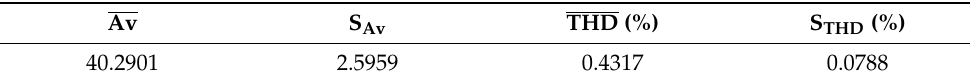
Table 5. Average and standard deviation values obtained from the Monte Carlo analysis with the